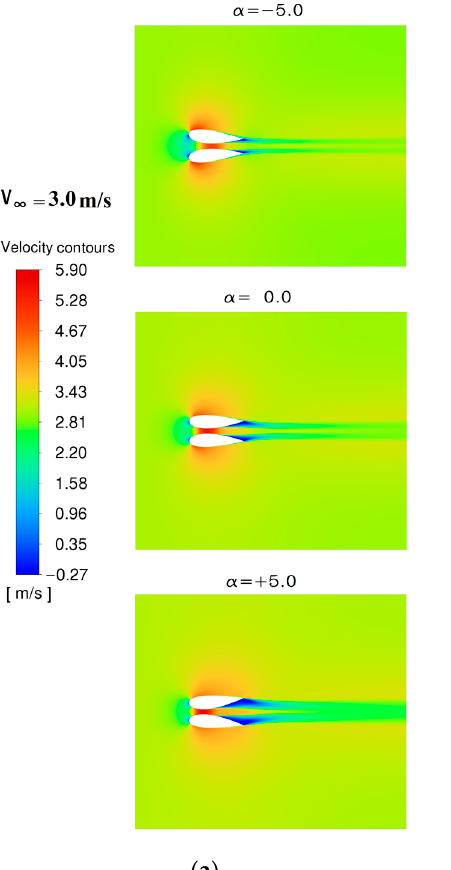
Figure 9. Center line velocity change along the augmentation system with different gaps and ( U ∞ = 5 m/s, +5° pitch angle). Figure 10. Center line velocity change along the augmentation system with different gaps ( U ∞ = 3 m/s, +5° pitch angle).